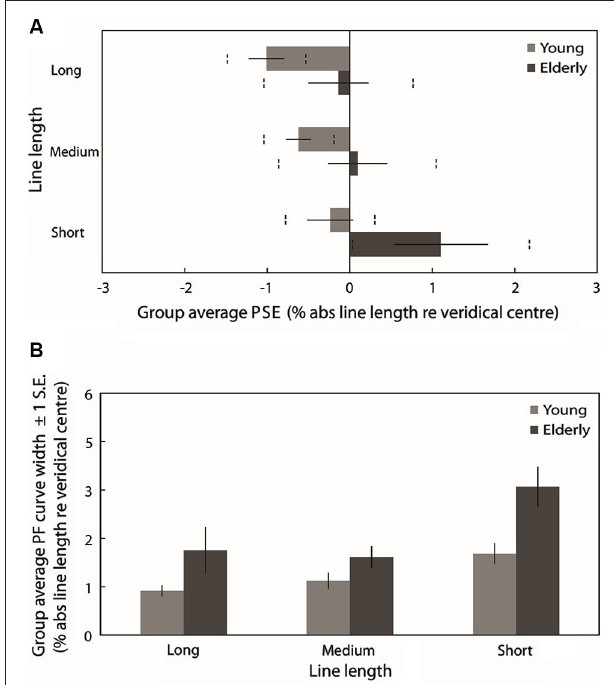
FIGURE 4 | (A) Group averaged PSE values ( ± 1 standard error (S.E.), vertical dashed lines represent 95% confidence intervals (CIs)) obtained from PFs fitted to the individual participants’ data for each line length. Light gray bars represent the young group and dark gray bars represent the elderly group. (B) Group averaged PF curve width ( ± 1 S.E.) obtained from PFs fitted to the individual participants’ data for each line